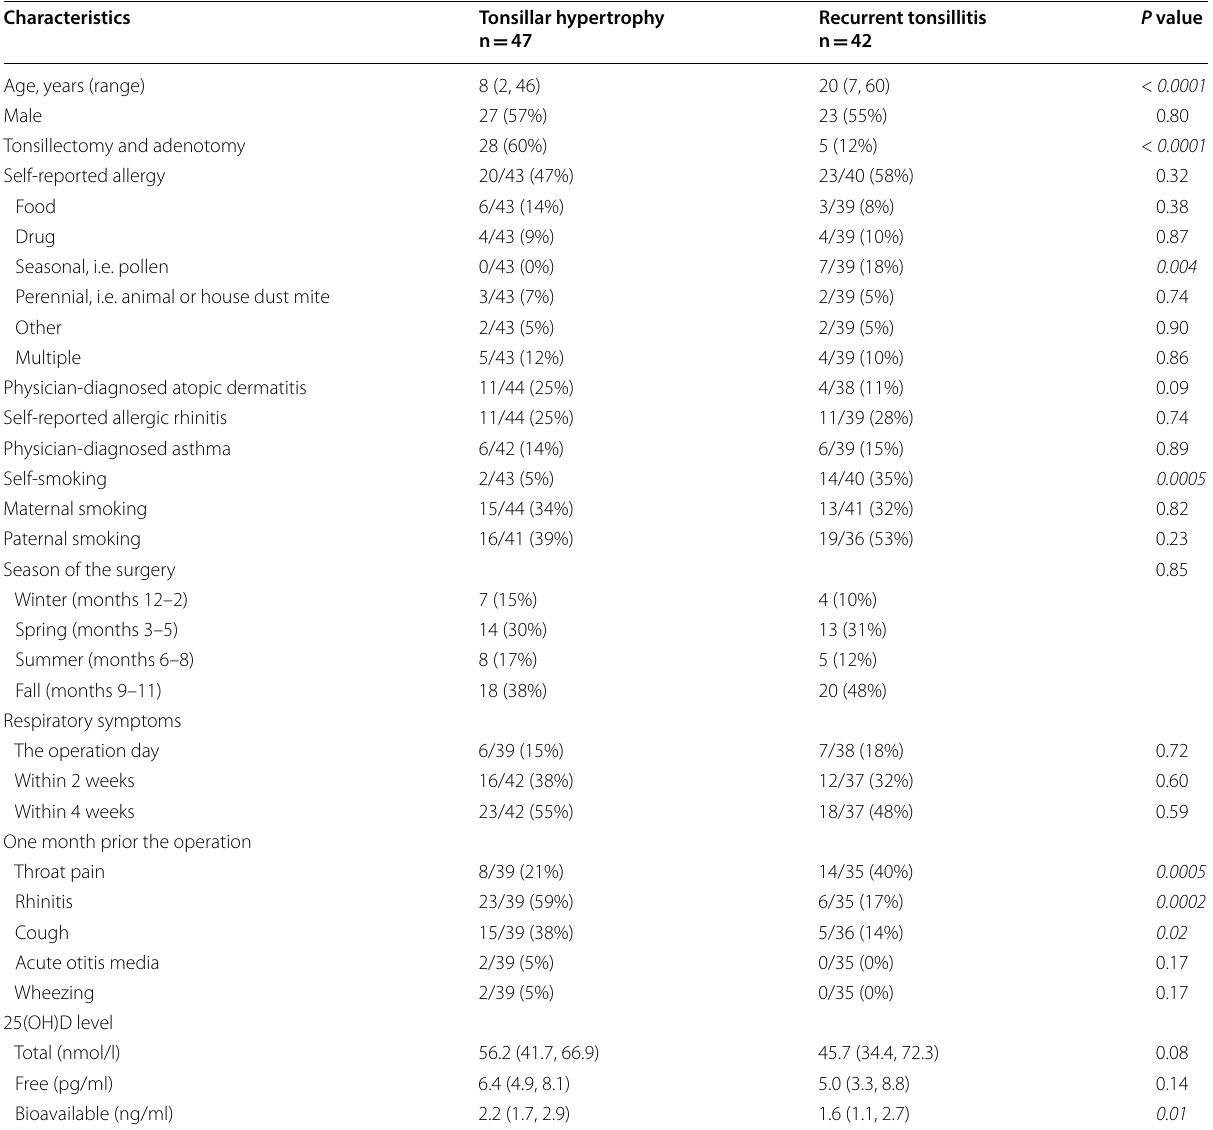
Table 1 Patient